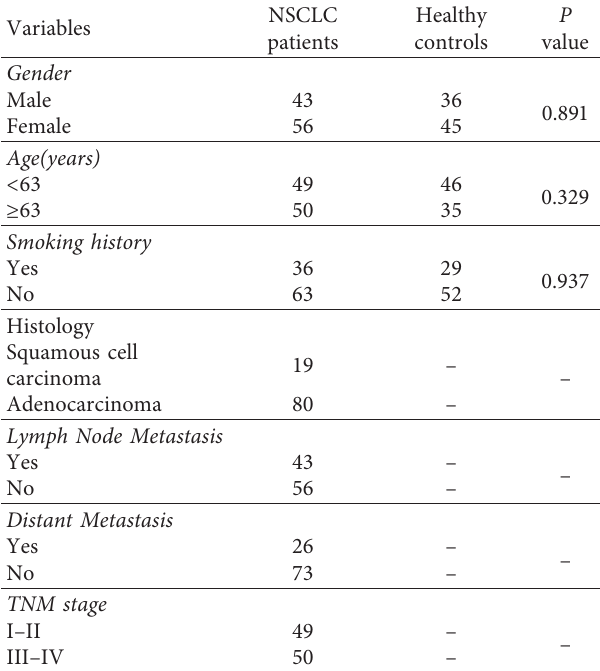
Table 1: Baseline characteristics of total patients, NSCLC patients, and healthy